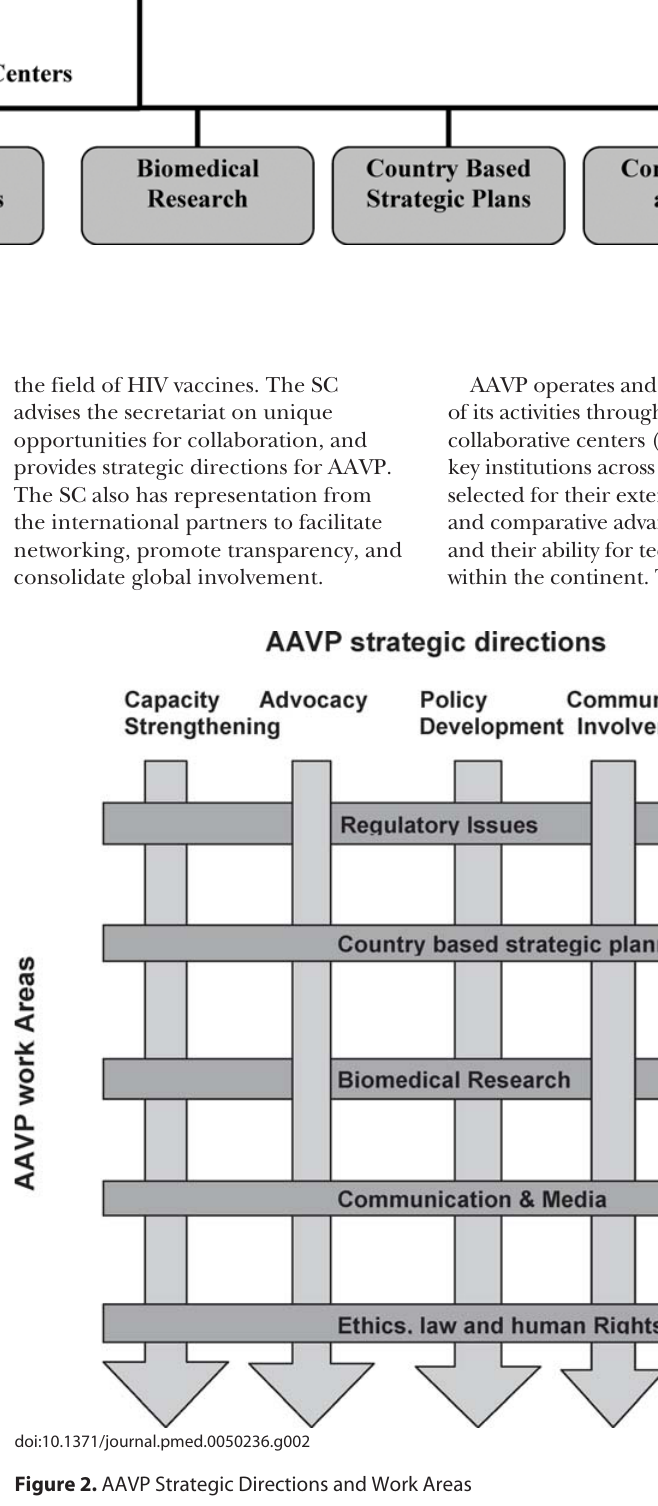
Figure 2. AAVP Strategic Directions and Work